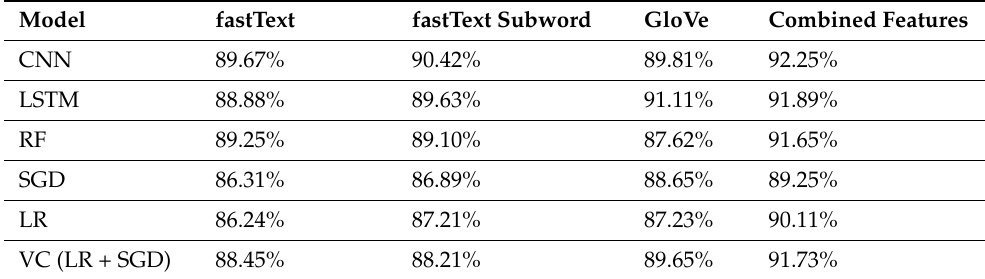
Table 7. Experimental results for dataset-2 using all